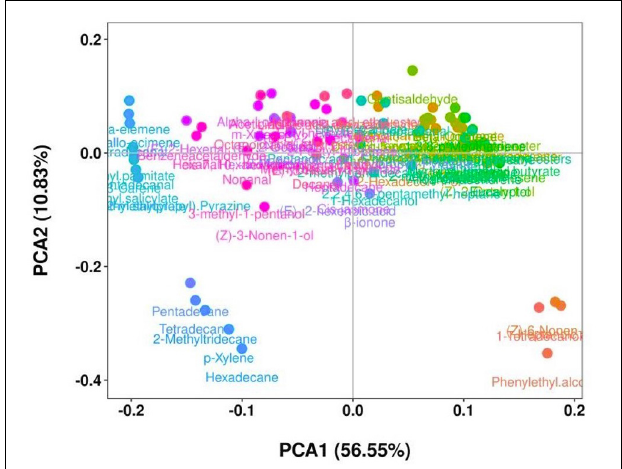
FIGURE 3 | Principal component analysis of volatile compounds of control and 1-MCP treated “Hangjiao No.2” chili peppers at different storage times at ambient